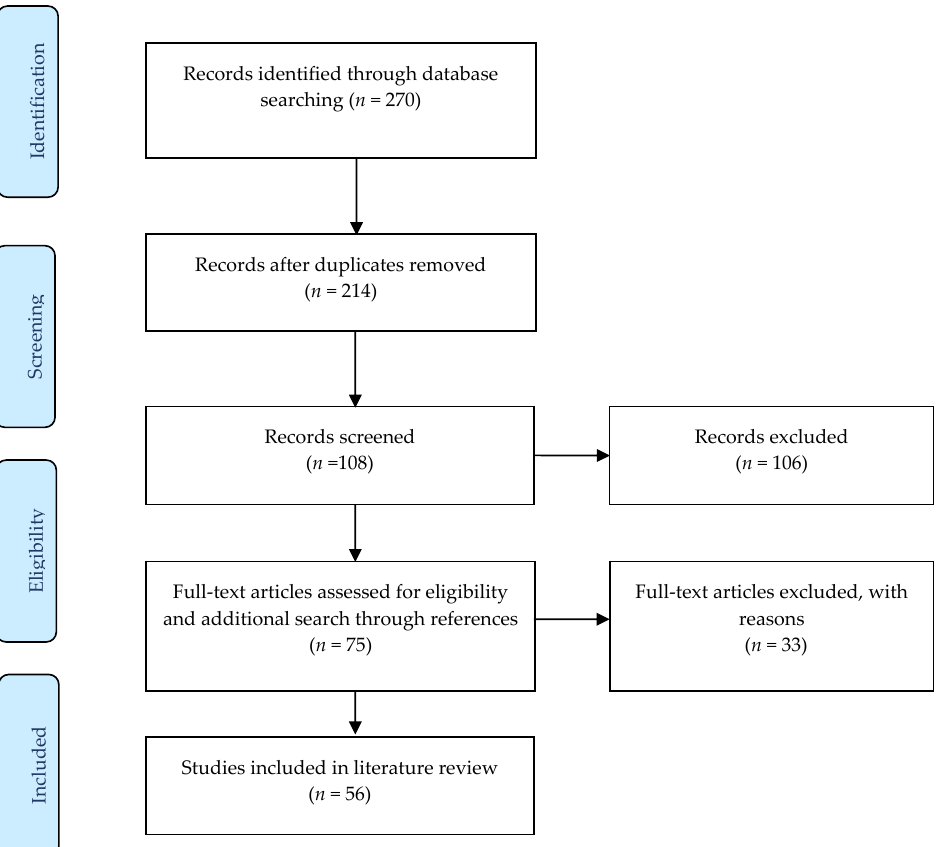
Figure 2. Preferred Reporting Items for Systematic Reviews and Meta-Analyses (PRISMA) chart of search strategy.